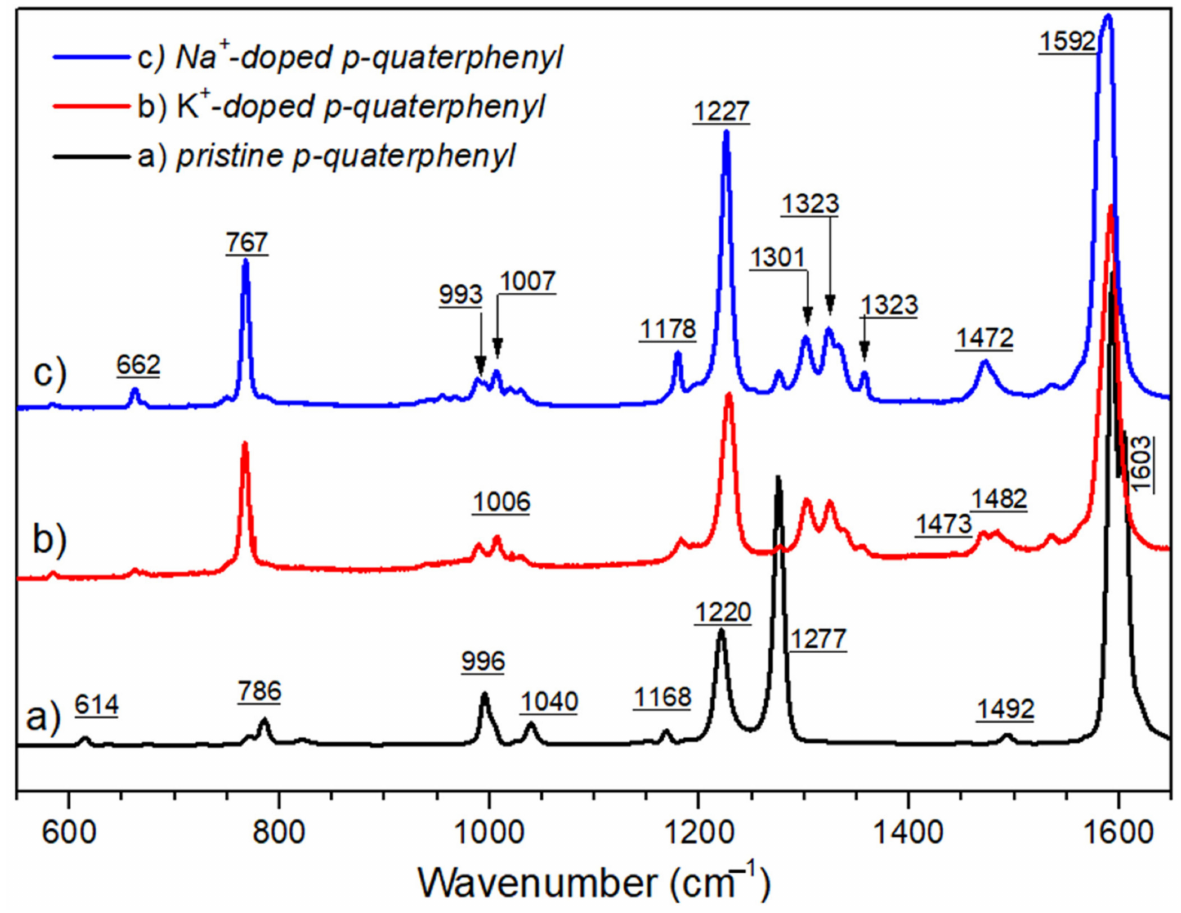
Figure 7. A comparison of Raman spectra of ( a ) pristine p -quaterphenyl, ( b ) K-doped, and ( c ) Na-doped quaterphenyl, with 514 nm as the excitation